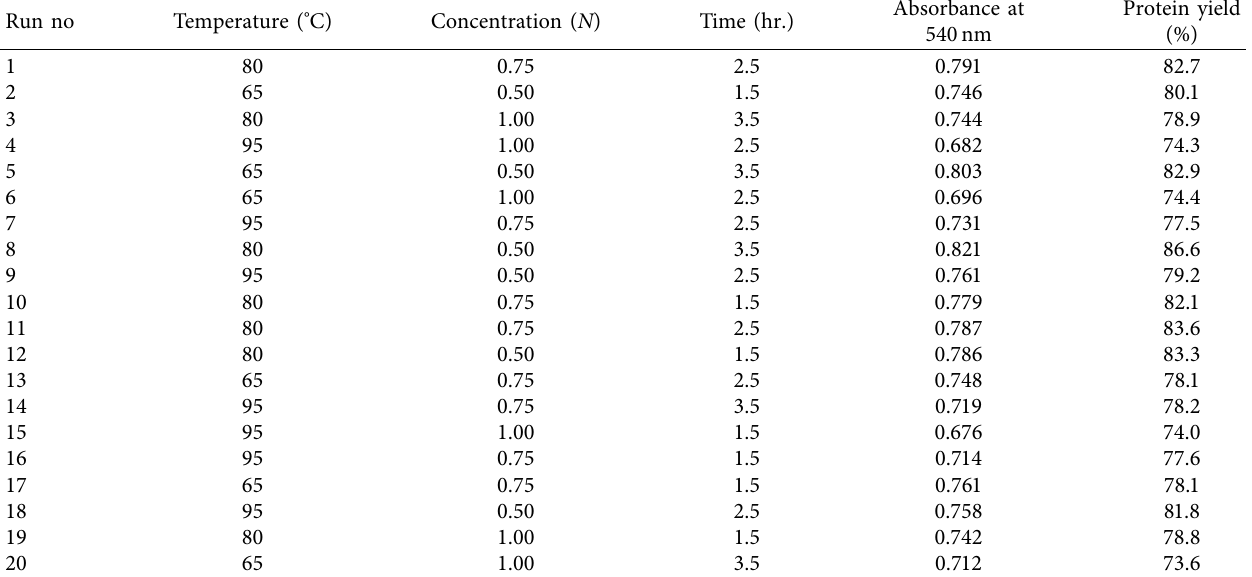
Table 6: Experimental responses of the predicted